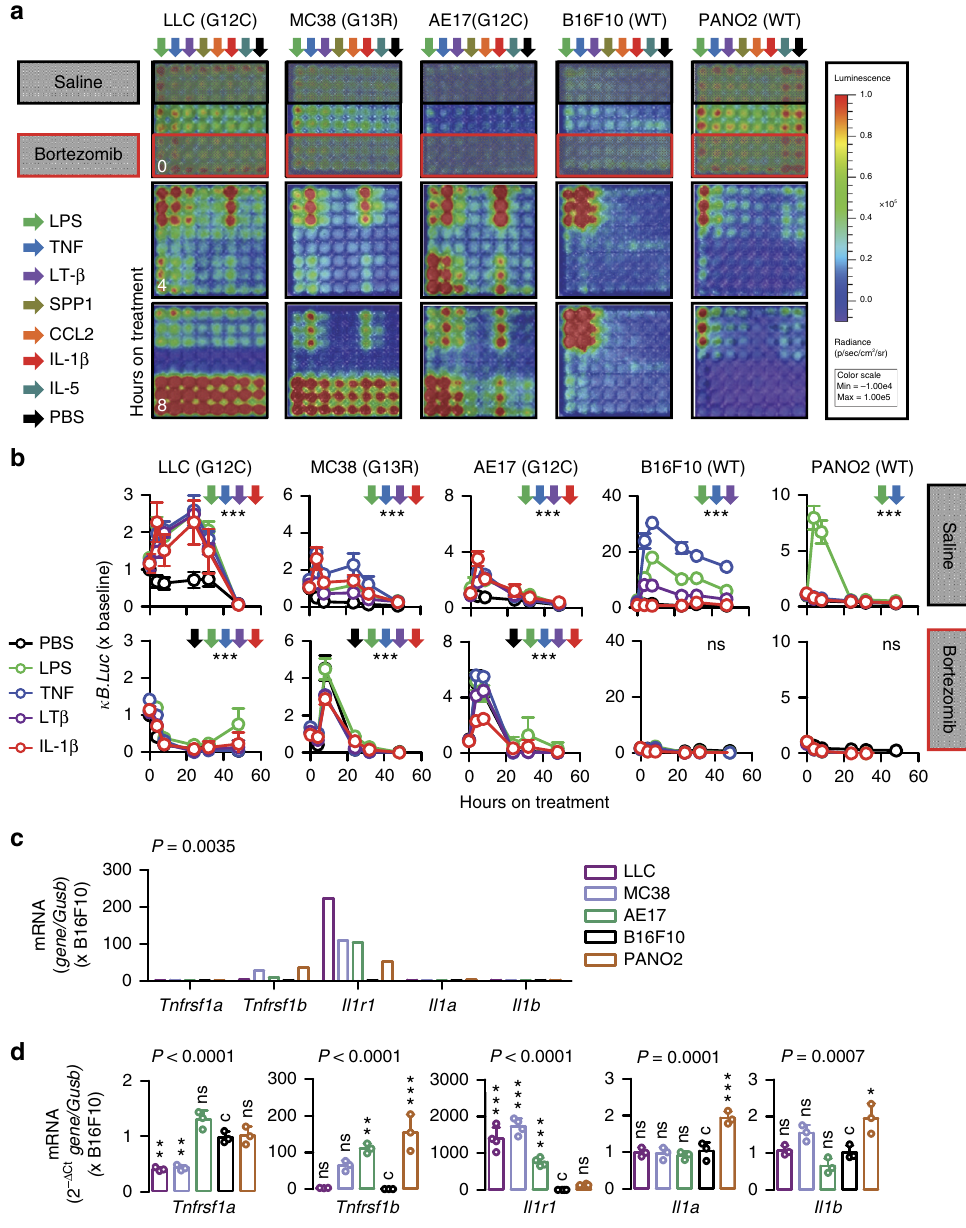
Fig. 2 Kras -mutant tumor cells possess IL-1 β -inducible NF- κΒ activity. Five different C57BL/6 mouse tumor cell lines with (LLC, MC38, AE17) or without (B16F10, PANO2) Kras mutations were assessed for inducible NF- κΒ activation in response to exogenous stimuli and for the expression of relevant receptors in vitro. a , b Representative bioluminescent images ( a ; shown are n = 3 replicates/data-point) and data summary ( b ; mean ± s.d. of n = 3 independent experiments) of cells stably expressing p NGL and pretreated with saline or 1 μ M bortezomib at different time points after addition of 1 nM of the indicated NF- κΒ ligands (arrows in a and legend in b ). Note NF- κ B inducibility by IL-1 β and bortezomib exclusively in Kras MUT cells. ns and *** P > 0.05 and P < 0.001, respectively, for comparison between ligands indicated by colored arrows and PBS at 4 and 8 h on treatment by two-way ANOVA with Bonferroni post-tests. c , d Tnfrsf1a , Tnfrsf1b , Il1r1 , Il1a , and Il1b mRNA expression relative to Gusb by microarray ( c ) and qPCR ( d ). Shown are mean ( c ) and mean ± s.d. ( d ) of n = 5 independent technical replicates of one biologic sample. P , probability of no difference between cell lines by two-way ( c ) or one- way ( d ) ANOVA. ns, single, double, and triple asterisks (*, **, and ***): P > 0.05, P < 0.05, P < 0.01, and P < 0.001, respectively, for comparison with B16F10 cells ( c ) by Bonferroni activation (Fig. 7a – d; Supplementary Table 3). Host-provided IL- C57BL/6 mice and drove them toward monocyte and neutrophil 1 β was of myeloid origin, since bone marrow (BM) trans- differentiation by macrophage colony-stimulating factor (M-CSF) plants 34,35 from C57BL/6 and Tnf − / − , but not Il1b − / − donors, to and granulocyte-colony-stimulating factor (G-CSF culture, lethally irradiated Il1b − / − recipients unable to foster MPE ren- respectively. Both BM-derived monocytes and neutrophils dered LLC cells MPE pro fi cient (Fig. 7e, f; Supplementary secreted IL-1 β upon 24-hour treatment with cell-free LLC Table 3). To de fi ne which myeloid cells provide the bulk of IL-1 β supernatants as measured by ELISA, but monocytes secreted to fuel tumor cell NF- κΒ activity, we isolated BM cells from